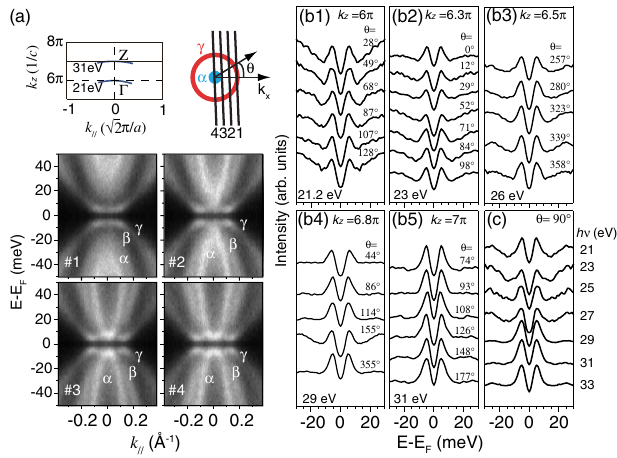
FIG. 2. (a) The photoemission intensities taken with 21.2 eV photons at 7 K near the zone center, as shown by cuts #1–#4 in the inset. The inset to the left shows the momentum cuts sampled by the 21- and 31-eV photons in the k x (cid:1) k z cross section of the extended Brillouin zone. (b) The symmetrized spectra at the marked polar angles on the (cid:3) Fermi surface measured at five typical k z values, with (b1) 21.2-, (b2) 23-, (b3) 26-, (b4) 29-, and (b5) 31-eV photons. (c) k z dependence of the symmetrized spectra measured on the (cid:3) Fermi surface of another sample at (cid:7) ¼ 90 (cid:2) . The 21.2-eV data were collected at 7 K with a helium lamp, while the others were collected at 1 K at